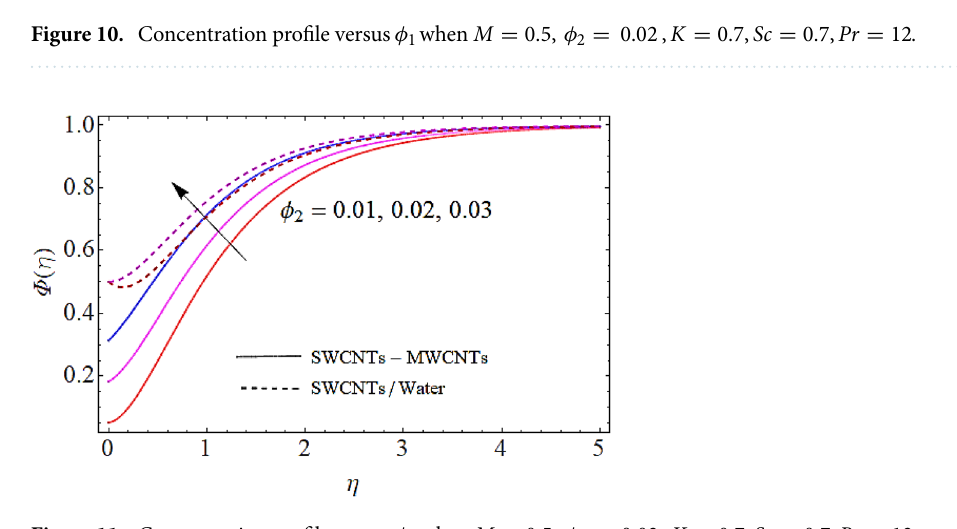
Figure 11. Concentration profile versus φ 2 when M = 0.5, φ 1 = 0.02, K = 0.7, Sc = 0.7, Pr = 12